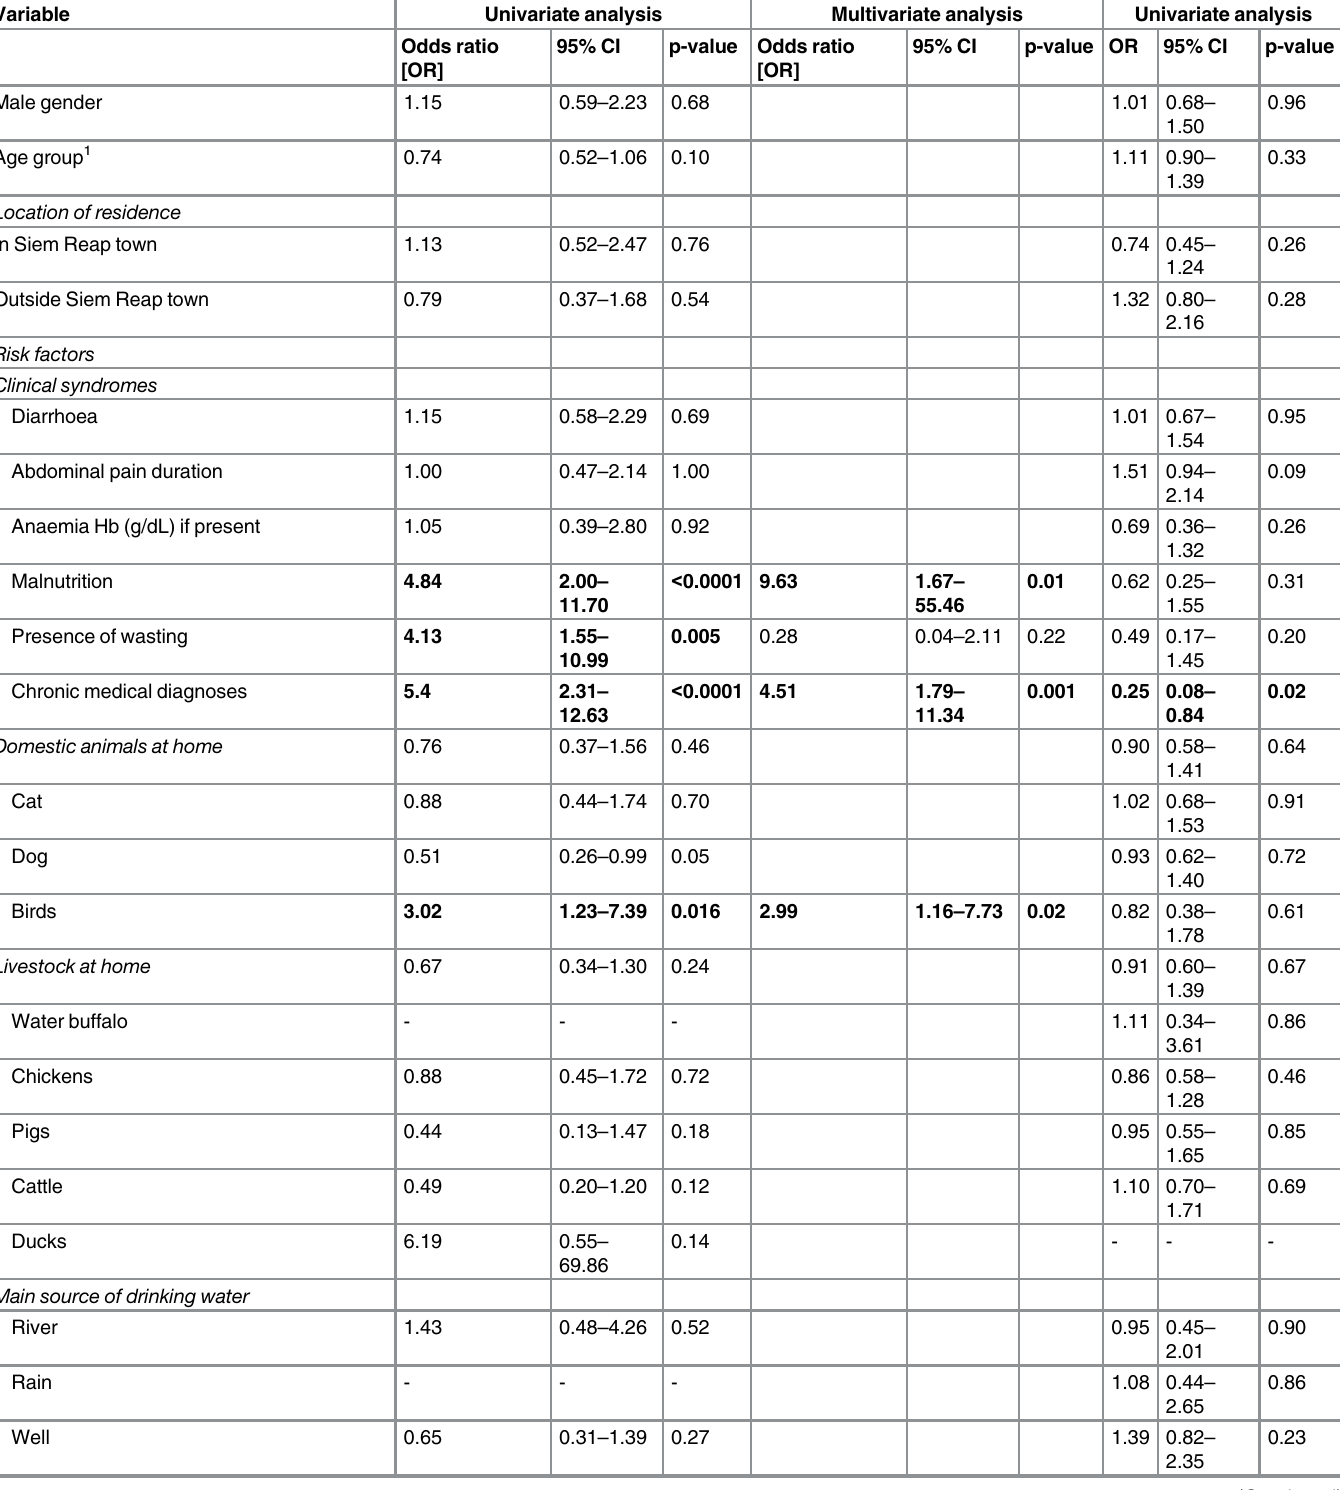
Table 2. Univariate and multivariate risk factor analyses for infections caused Cryptosporidium spp. and Giardia duodenalis , data available in S2